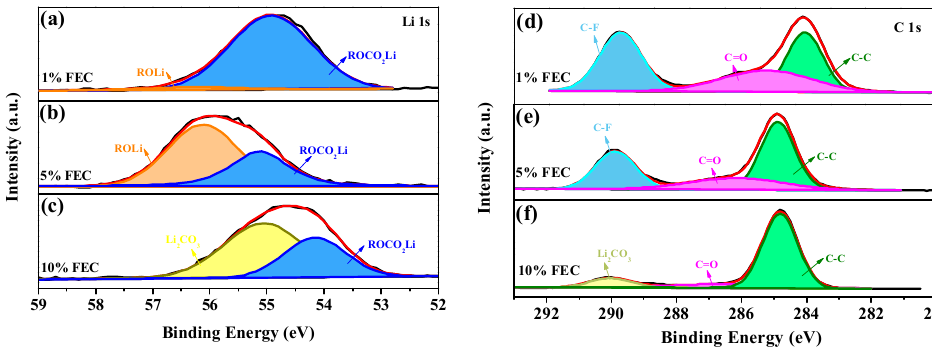
Figure 5. XPS spectra of Li 1s and C 1s in 1% FEC-RT-1D battery ( a , d ), 5% FEC-RT-1D battery ( b , e ) and 10% FEC-RT-1D battery ( c , f ).